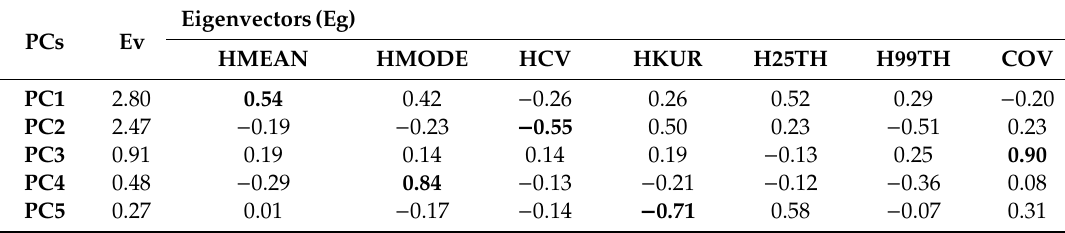
Table 5. Loadings and eigenvectors for the first five principal components